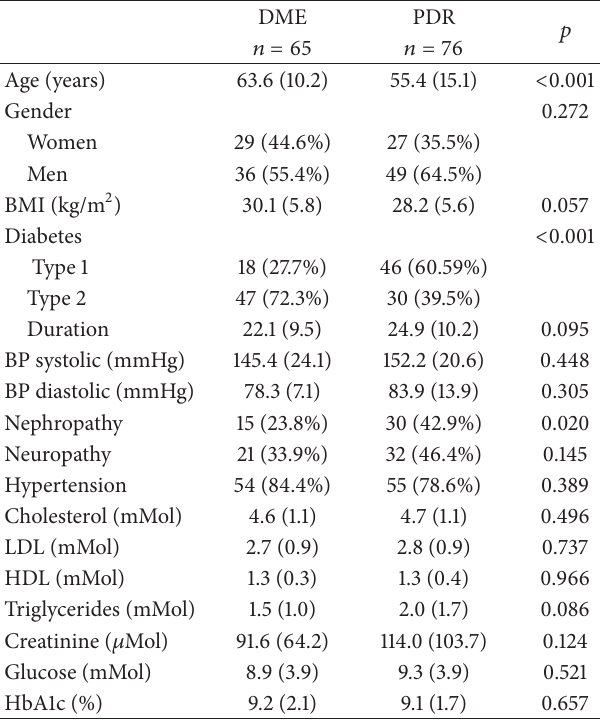
Table 2: Clinical characteristics of the diabetic retinopathy patients (DR) with diabetic macular edema (DME) or proliferative retinopa- thy(PDR).Thedataareexpressedasmean(standarddeviation(SD)) or 𝑛 (percent (%)).